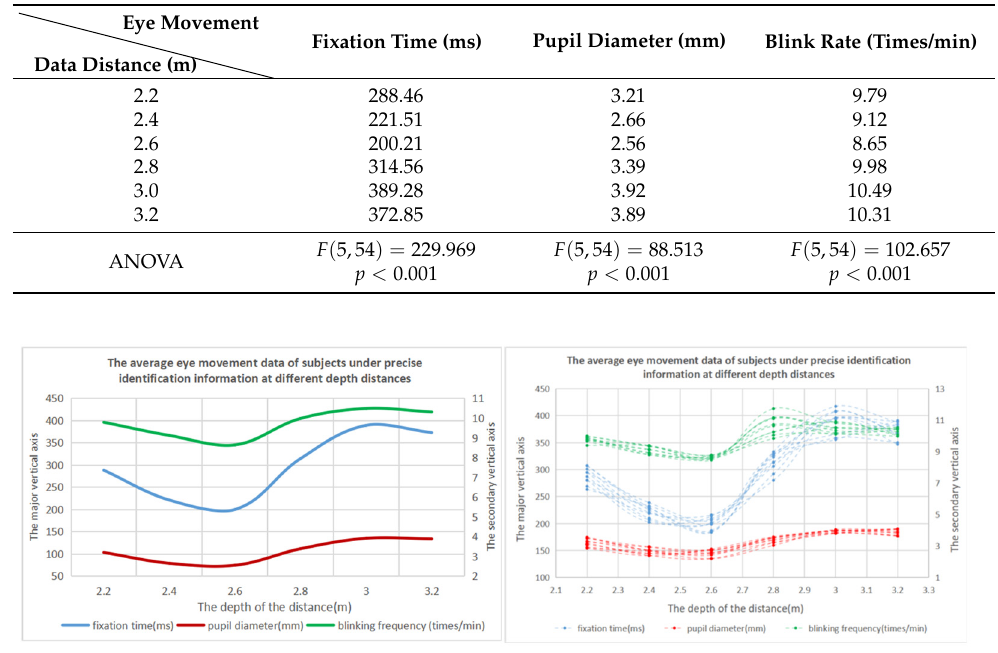
Table 7. Average eye movement data after the depth and distance range of the accurate identifica- tion information is divided.